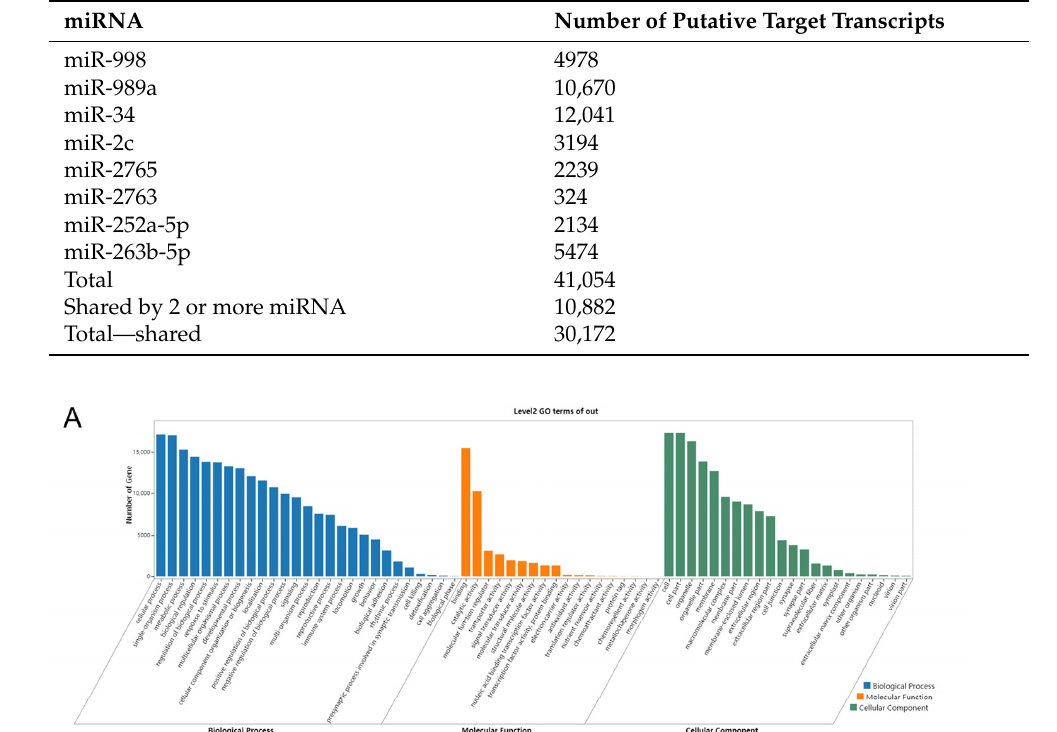
Table 2. Numbers of putative target transcripts of the eight validated testis- or ovary-biased miRNAs.